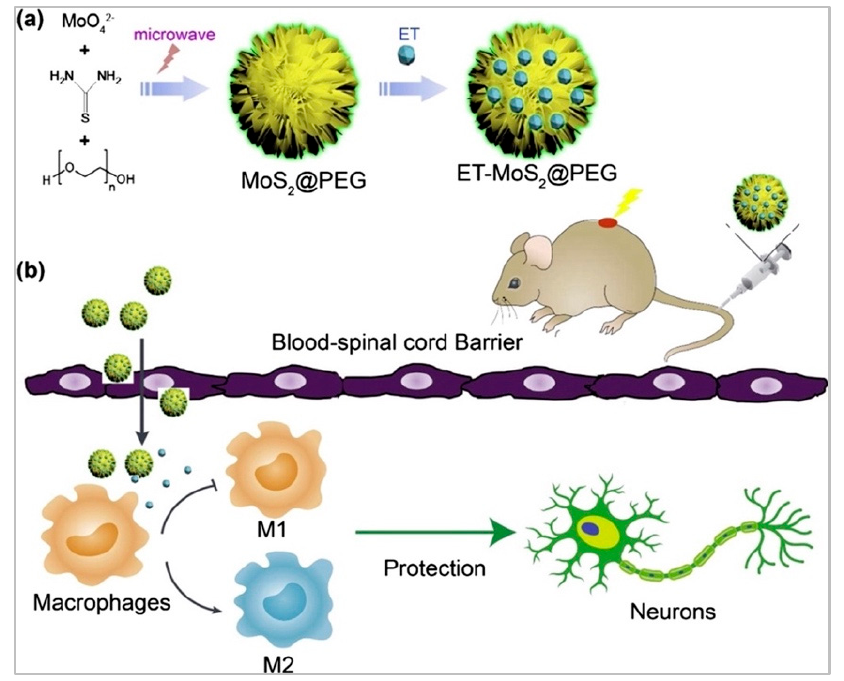
Figure 4. Schematic illustration of ( a ) the synthesis procedure for ET-MoS2@PEG nanoflowers, and ( b ) their application in SCI treatment as anti-inflammation devices. Reprinted with permission from